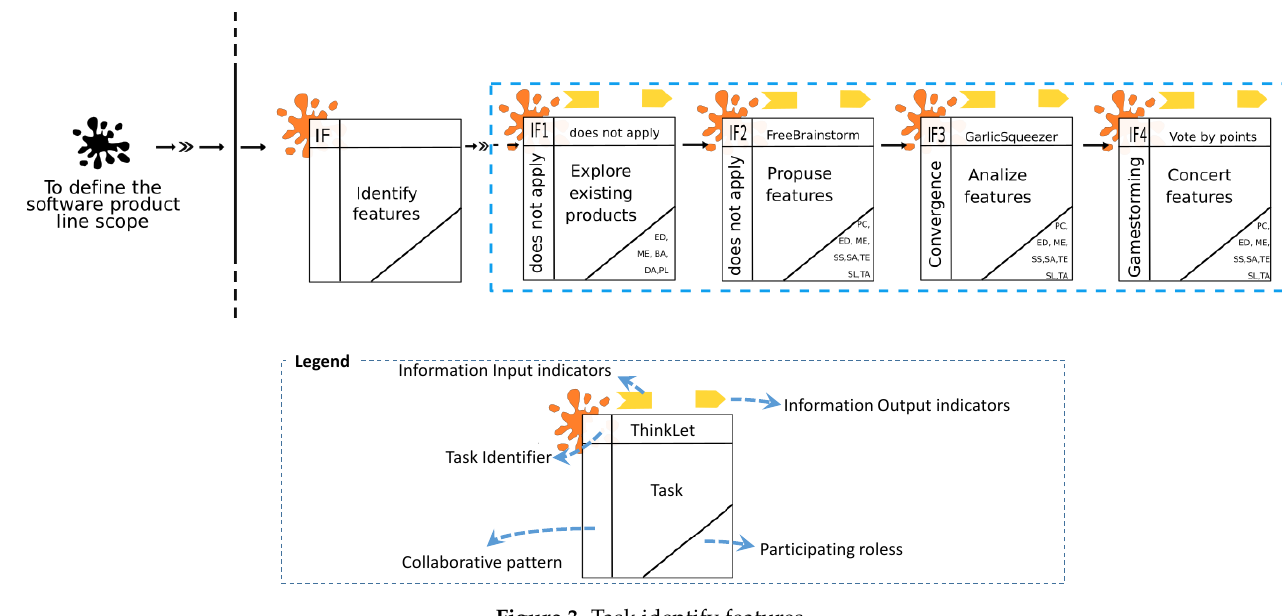
Figure 3. Task identify